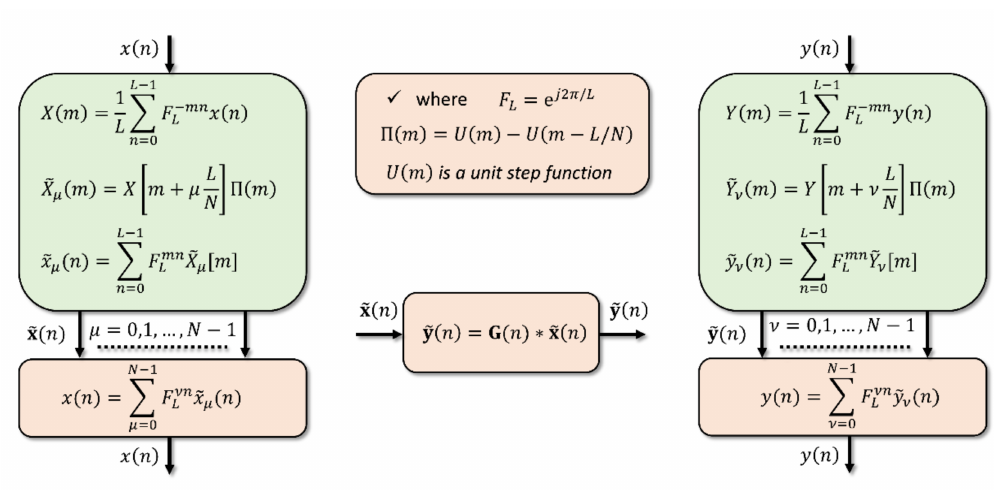
Figure 5. Scheme of frequency shift